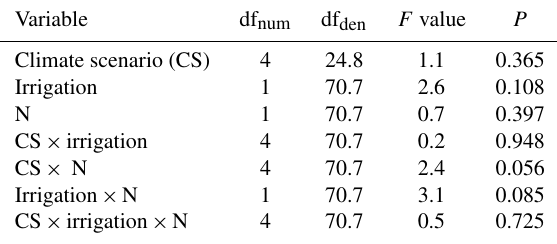
Table B3. Summary of analyses for the effects of climate scenario (CS), irrigation and N deposition on shoot carbon stock of subalpine grassland in 2017, after 5 years of experimental treatment. F tests refer to the fixed effects of a linear mixed-effects model; the marginal and conditional R 2 values were 0.16 and 0.32, respectively. No data were available for CS1 and the intermediate N-deposition treatment N3. df num df